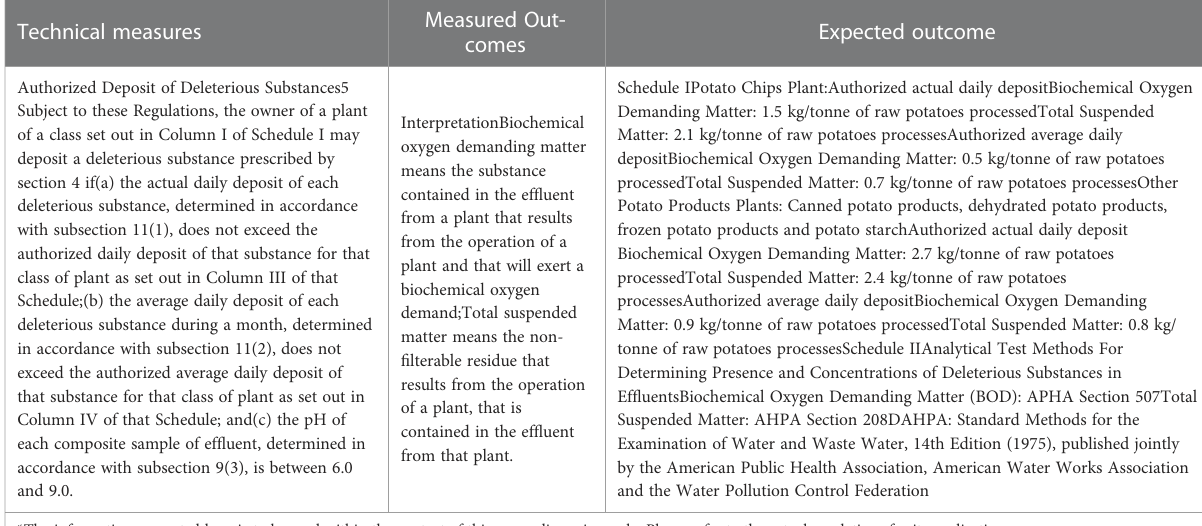
TABLE 4 Fisheries Act (R.S.C., 1985, c. F-14): Potato Processing Plant Liquid Ef fl uent Regulations (C.R.C., c. 829)* (Canada, 2019). Technical measures